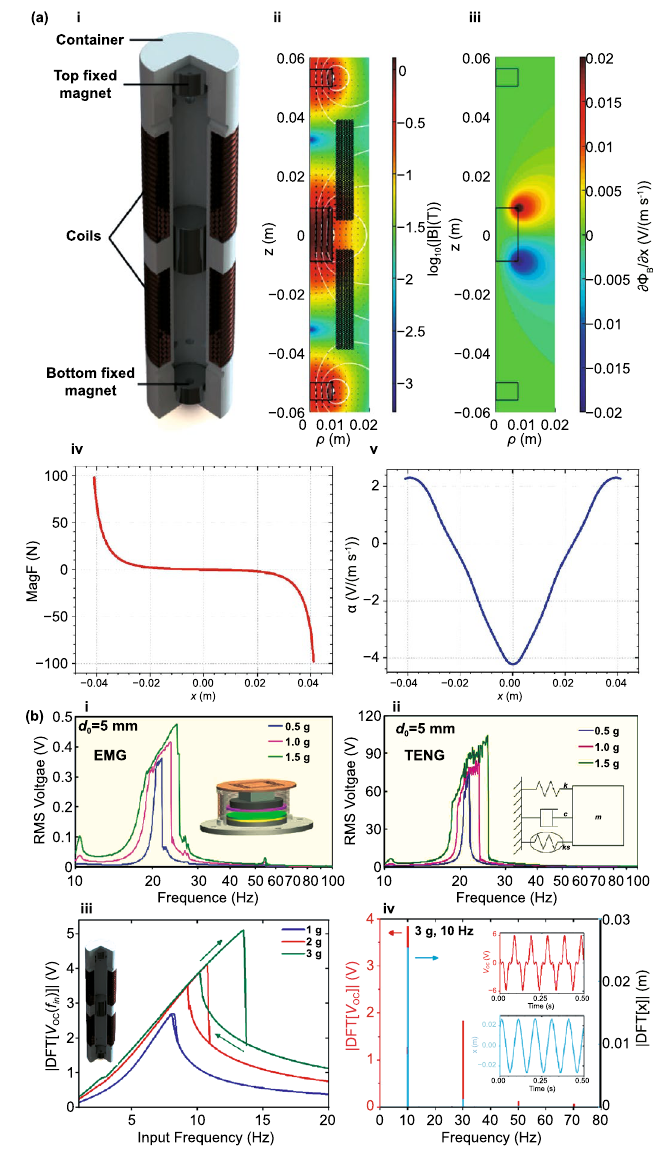
Fig. 7 a Schematic representation of a cylindrical resonant magnetic levitation EMG. (i) Section view of the levitating system composed of a central free levitating magnet, two fixed magnets with a different magnetization direction and two wound up coils. Reproduced with permission from Ref. [153]. Copyright 2020, Applied Energy. (ii) Magnetic induction field ( B ) lines (in white) and direction arrows (in black) and cor- responding absolute value in color scale. (iii) Variation of the magnetic flux ( ΦB ) through a loop of wire with the variation of the position of the free-magnet ( x ), equivalent to the electromechanical coupling factor ( α ) for a single loop. (iv) Total magnetic restoring force (Mag) exerted on the free-magnet vs position of the magnet calculated using Bessel functions. (v) Electromechanical coupling coefficient ( α ) for the two coils connected in series versus position of the magnet calculated using elliptic integrals. b Experimental frequency response of a nonlinear impact resonant hybrid generator with a coupled (i) magnet–spring–coil EMG and (ii) contact-separation TENG to a harmonic input with acceleration amplitudes of 0.5 g, 1.0 g and 1.5 g. The frequency here was swept from lower to higher values, showing a broad hardening resonant peak, at higher accelerations, of the OC RMS voltage with two critical points at ca. 19 Hz and 25 Hz similarly to a Duffing oscillator’s response. For the lower acceleration of 0.5 g, the system behaves ca. as in the linear regime characterized by a simple sharp resonant peak at ca. 21 Hz. Adapted from Ref. [90]. (iii) Absolute value of the discrete Fourier transform (DFT) of the OC voltage (at the same frequency as the input) response of the cylindrical nonlinear magnetic levitation EMG to a harmonic input with acceleration amplitudes of 1 g, 2 g and 3 g, and with increasing and decreasing frequency numerically calculated. (iv) Absolute values of the discrete Fourier transforms of the OC voltage ( V OC ) and displace- ment ( x ) as a function of the output frequency for the same system, with an input excitation of 3 g and 10 Hz, and corresponding time responses shown in the insets. (Color figure